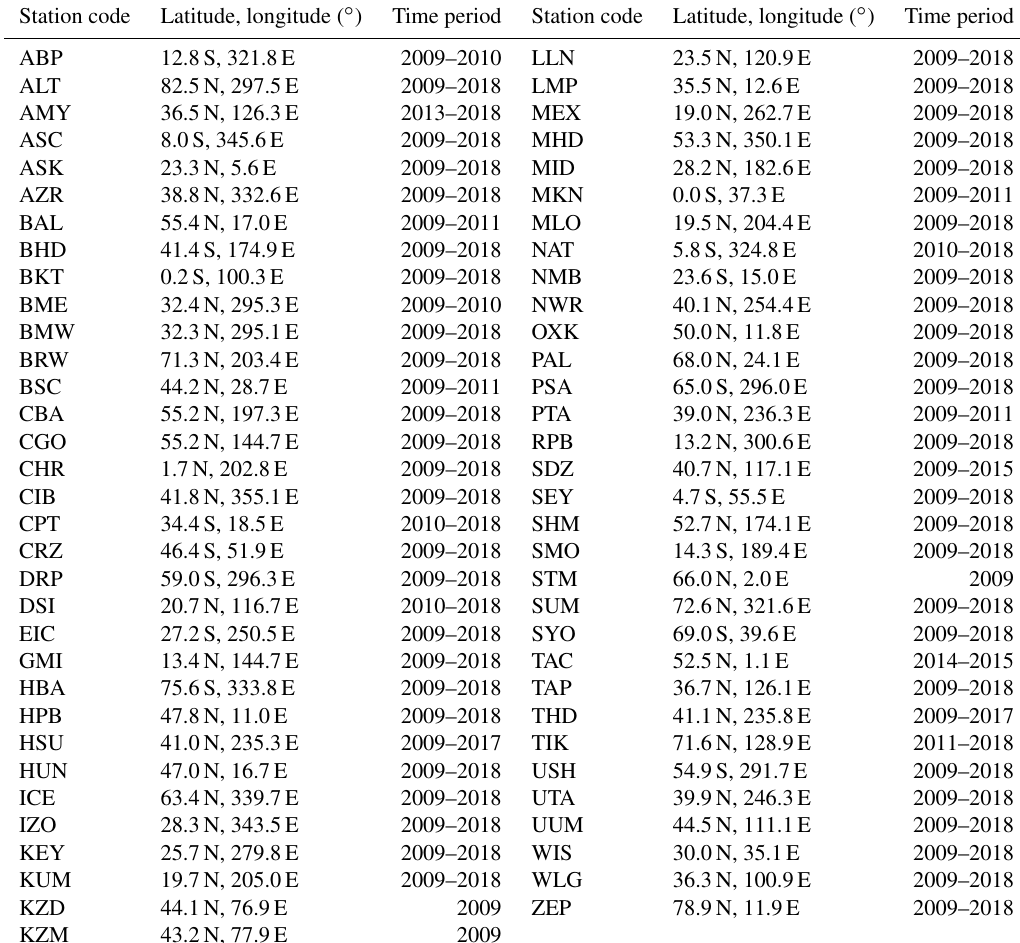
Table A1. Locations and time periods covered by surface flask samples used in inversions, provided by the National Oceanic and Atmospheric Administration’s Global Monitoring